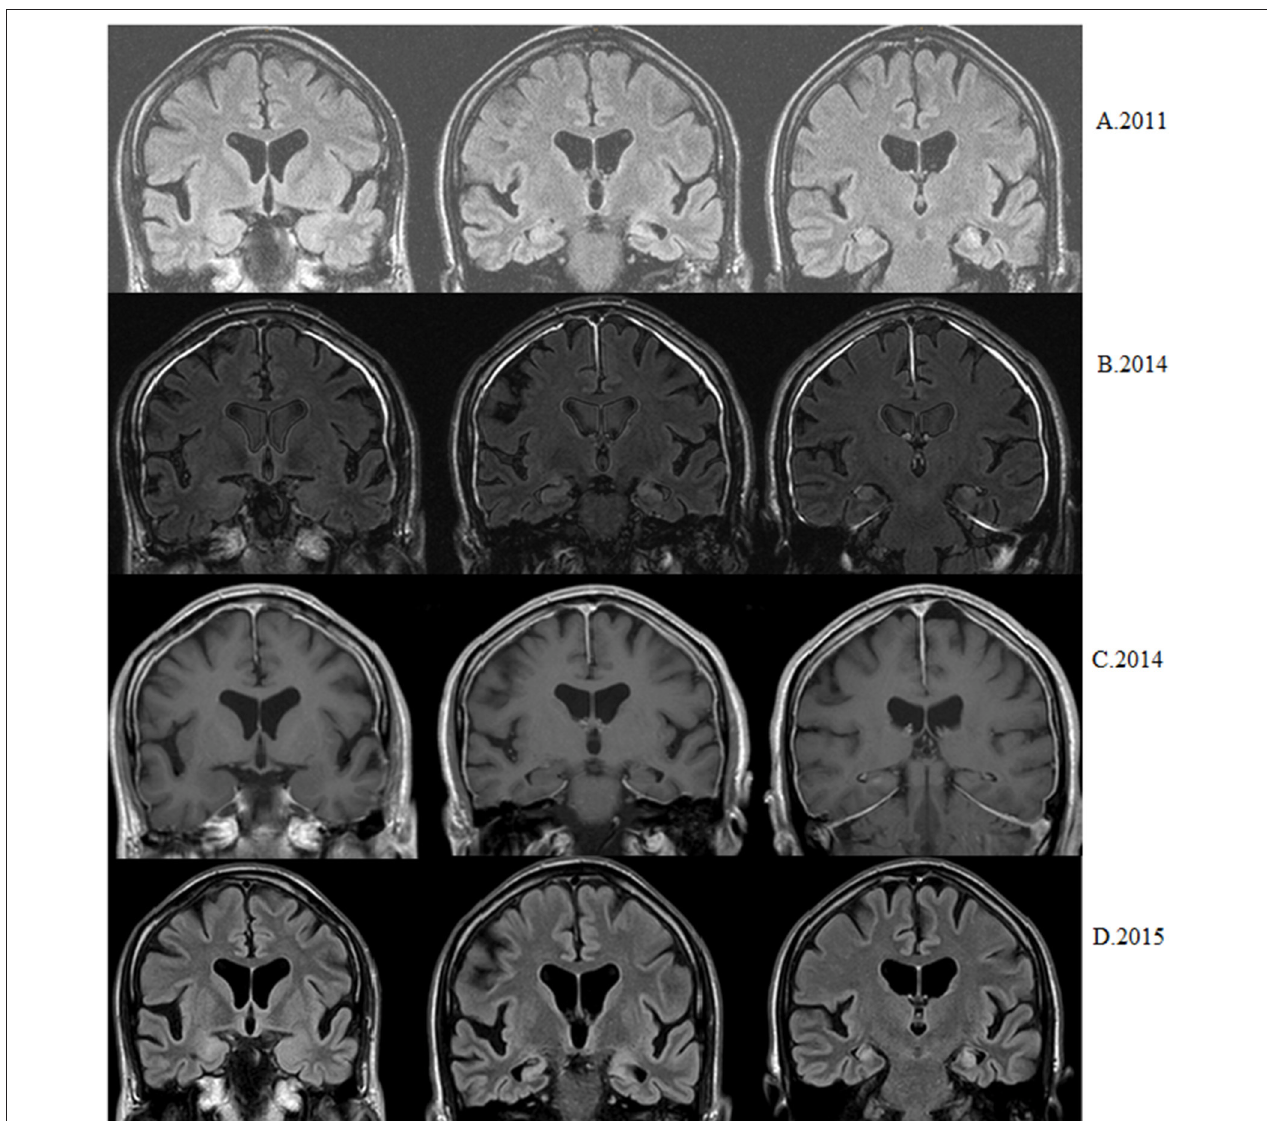
FIGURE 2 | Patient with epilepsy debut at 56. Nowadays seizure-free but with progressive memory decline. (A) First available MRI shows left hippocampal atrophy and hyperintensity (coronal flair). (B) Three years later bilateral hippocampal hyperintensities are observed without right hippocampal atrophy (coronal flair). (C) Three years later nodular right hippocampal contrast enhancement is observed (coronal T1 after injection of gadolinium). (D) After 6 months bilateral hippocampal sclerosis (atrophy + hyperintensity) is observed (coronal flair).